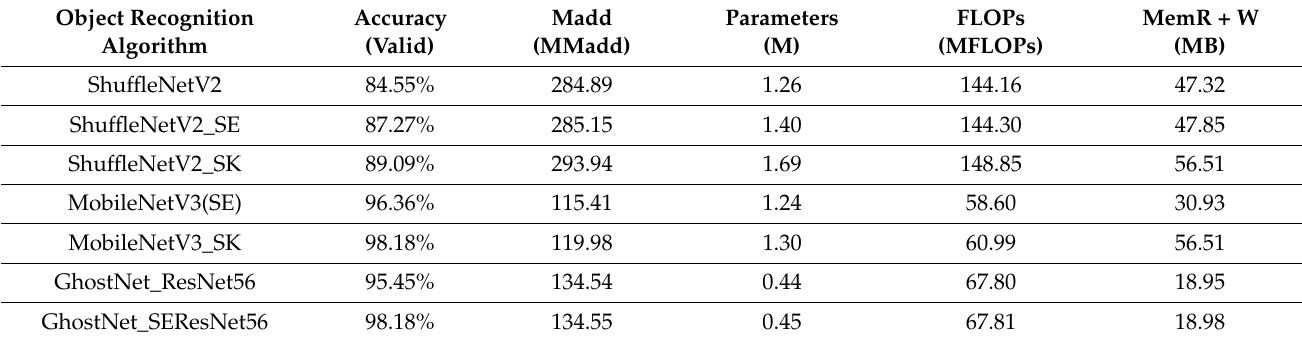
Table 4. Comparison of prediction results and performance of three series lightweight neural network.